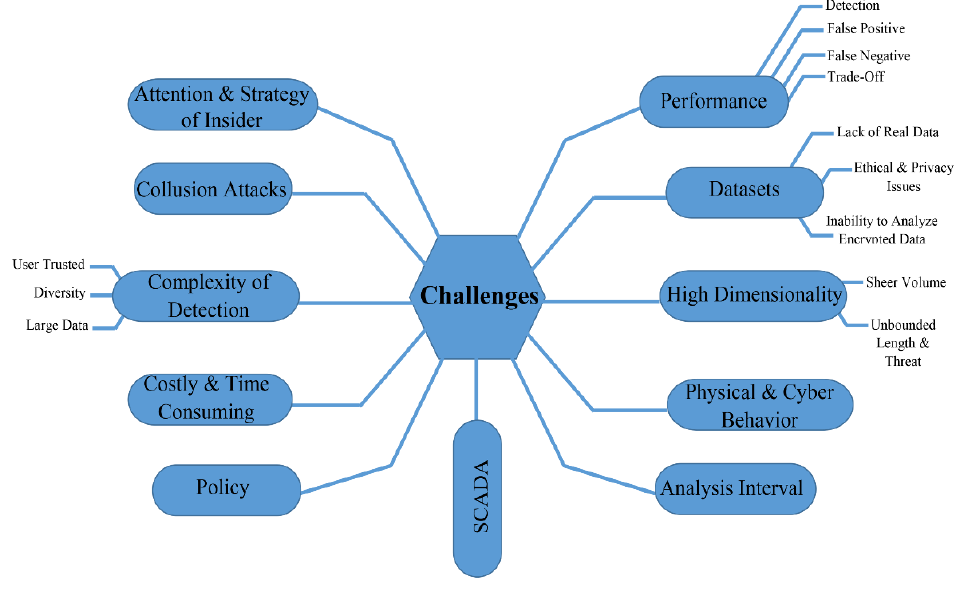
Figure 9. Figure 9. Challenges.